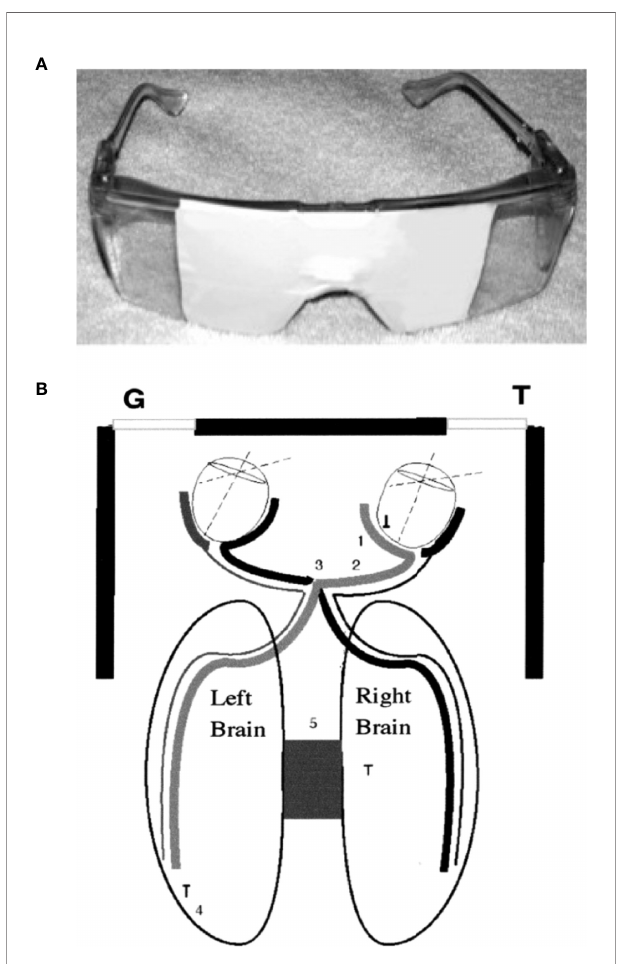
FIGURE 1 | (A) Taped safety glasses used in the experiment. (B) A diagram of how looking to the left allowed vision primarily out of the LVF and looking to the right allowed vision primarily out of the RVF. (1) Nasal retina; (2) optic nerve; (3) optic chiasm; and (4) occipital cortex. The diagram shows how the medial retina receives light from the lateral visual fi eld and transfers information to the contralateral hemisphere. These neurological facts were used extensively in the split-brain studies, and we assume that the personality changes described here and in our other publications use a similar mechanism